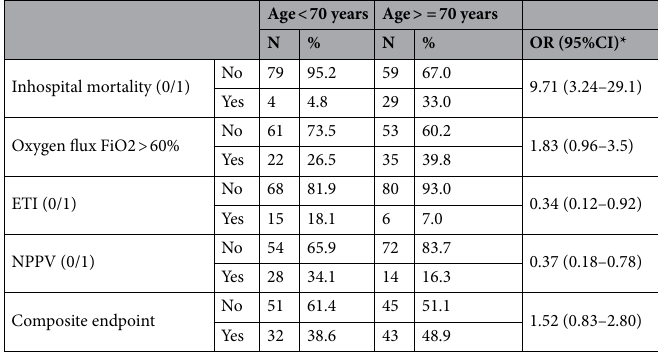
Table 3. Occurrence and comparison of endpoints in patients over and under 70 years old. *Odds Ratio and 95% Confidence Interval. Reference category: absence of the condition or FiO2 ≤ 60. ETI = endotracheal intubation, NPPV = non-invasive positive pressure ventilation.